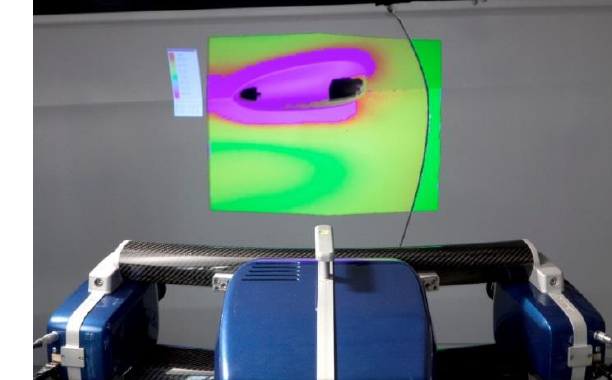
Figure 13: Backprojection of color deviation